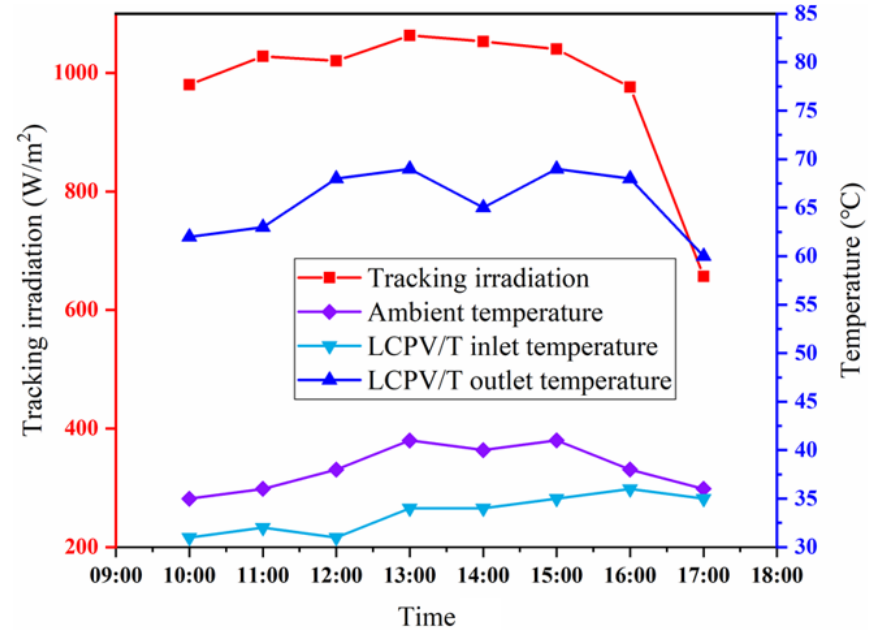
Figure 4. Variation trend of inlet/outlet temperature of LCPV/T module.